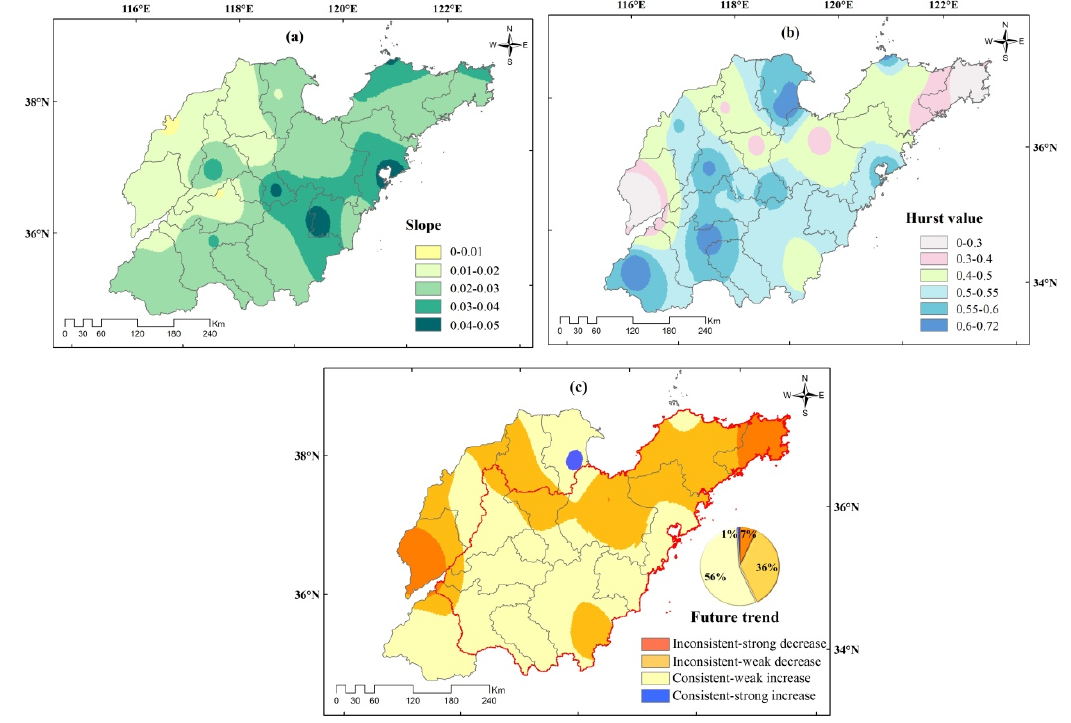
Figure 6. Spatial distribution of trends in variation ( a ), Hurst values ( b ) and future trend ( c ) of SPI in Shandong Province during the period 1981–2012.